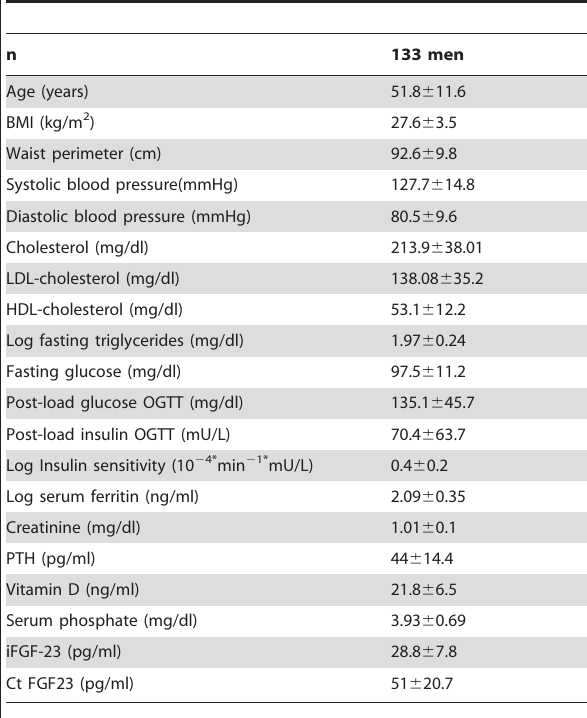
Table 1. Anthropometrical and biochemical characteristics of the study subjects in Cohort 1.